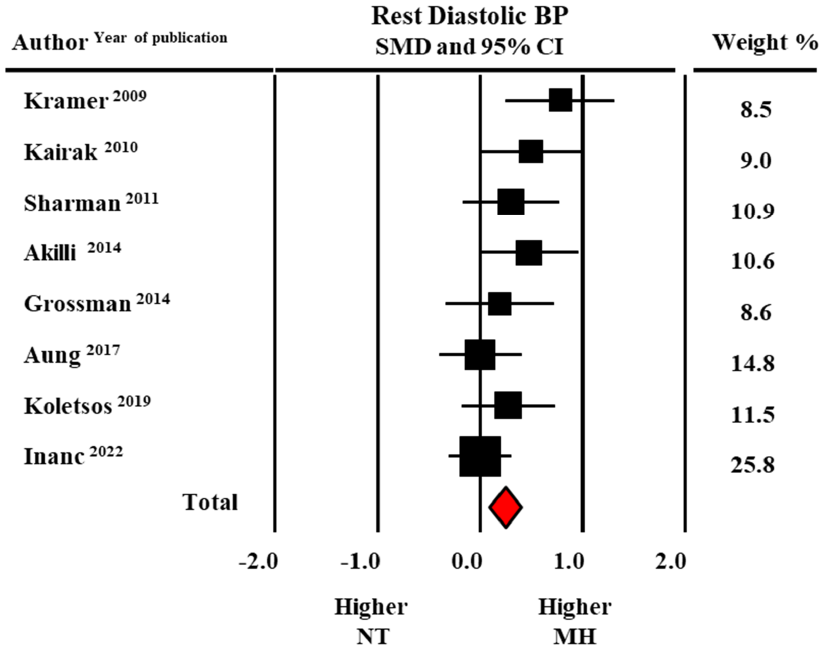
Figure 3. Forest plot of diastolic blood pressure (BP) at rest in masked hypertensive (MH) and normotensive (NT) individuals. Standard mean difference (SMD) and 95% confidence interval (CI). Fixed model [21–27,29].